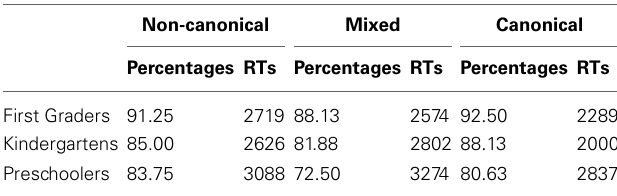
Table 3 | Percentages of correct responses and reactions times (in ms) in the comparison of finger numerical pattern task as a function of school levels and finger configurations.